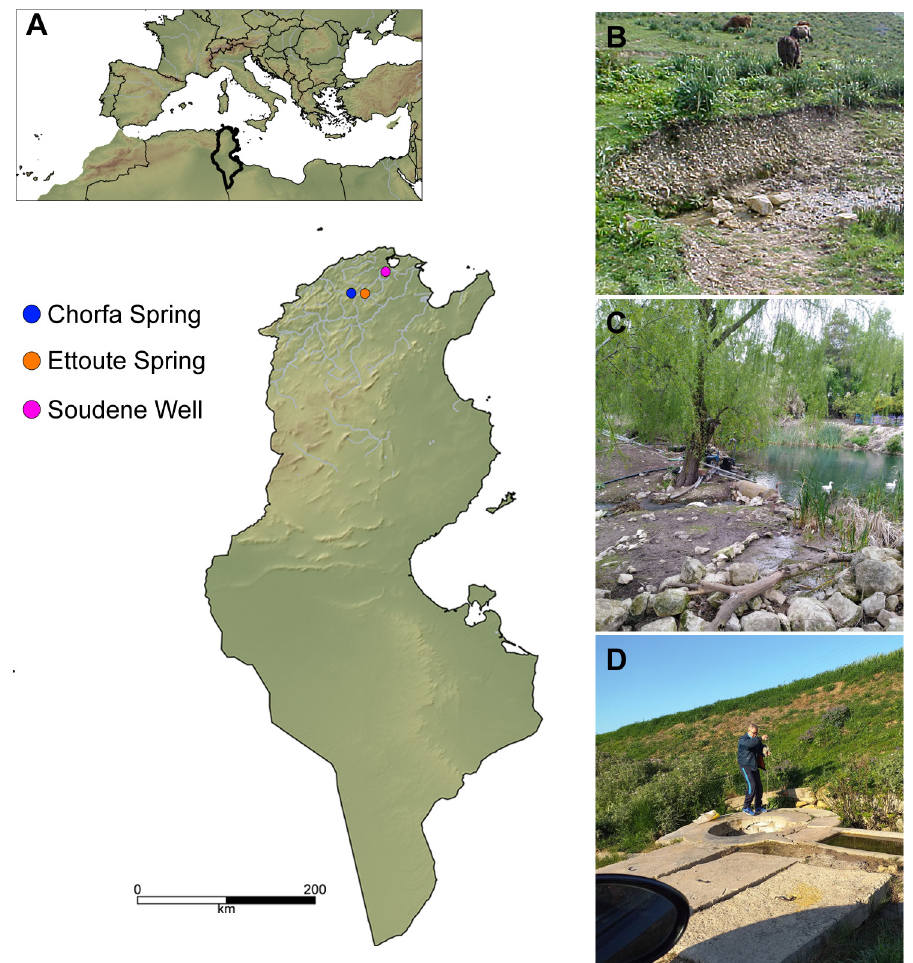
Fig. 1. Map and photographs of the collecting localities. A . Map showing the collecting localities in Tunisia. B . Chorfa Spring, Province Béja. C . Ettoute Spring, Province Bizerte. D . Soudene Well